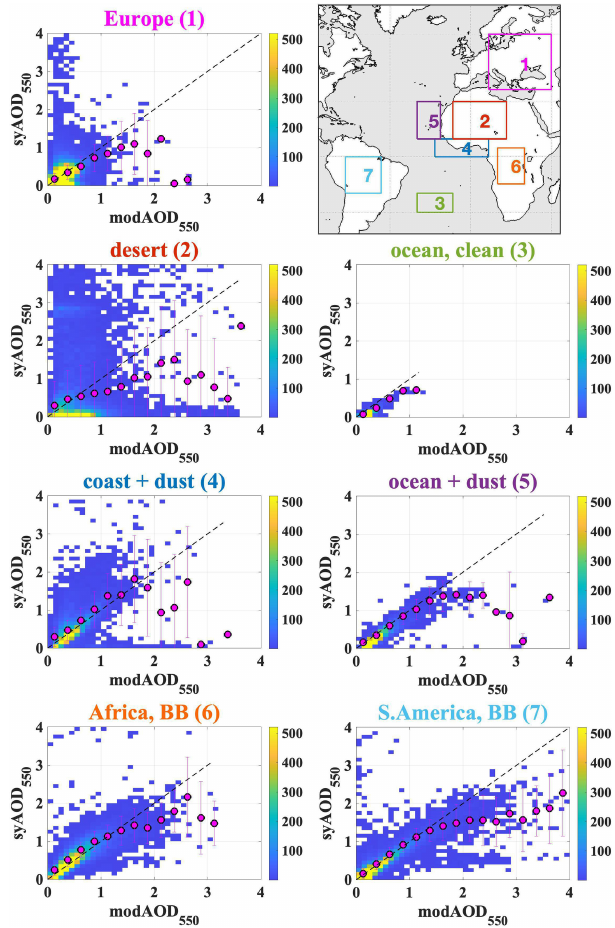
Figure 29. Density scatter plots for MODIS Terra and S3A SY_2_AOD L3 daily collocated products for 2020 for the subre- gions shown in the top right corner. Statistics are summarised in the Supplement (Table